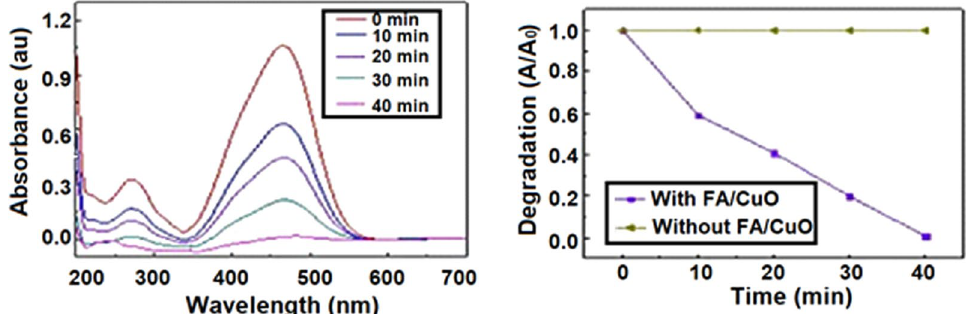
ing of photocatalysts with metals from CFA ( c ) Surface features and porosity of CFA-based catalysts for light absorption ( d ) Photocatalyst coated on CFA (Mushtaq et al. 2019)